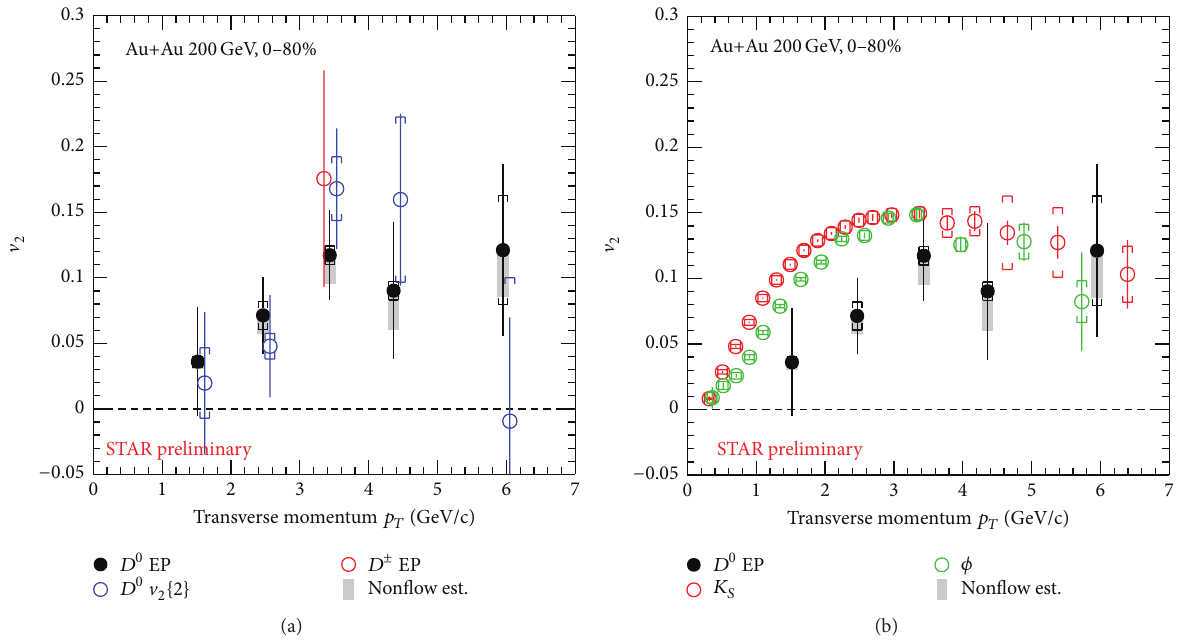
Figure 6: (a) The elliptic flow of 𝐷 0 and 𝐷 + meson as a function of 𝑝 𝑇 in minimum bias (0–80%) Au+Au collisions at √𝑠 NN = 200 GeV [32]. (b) V 2 for 𝐷 0 compared to that of light mesons ( 𝐾 0 𝑆 and 𝜙 ) [33, 34]. The vertical error bars represent the statistical uncertainty; the cap symbols are the systematic